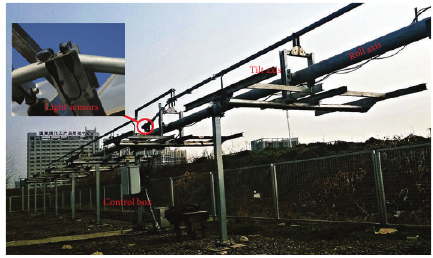
Figure 4: Photograph of the dual-axis tracking